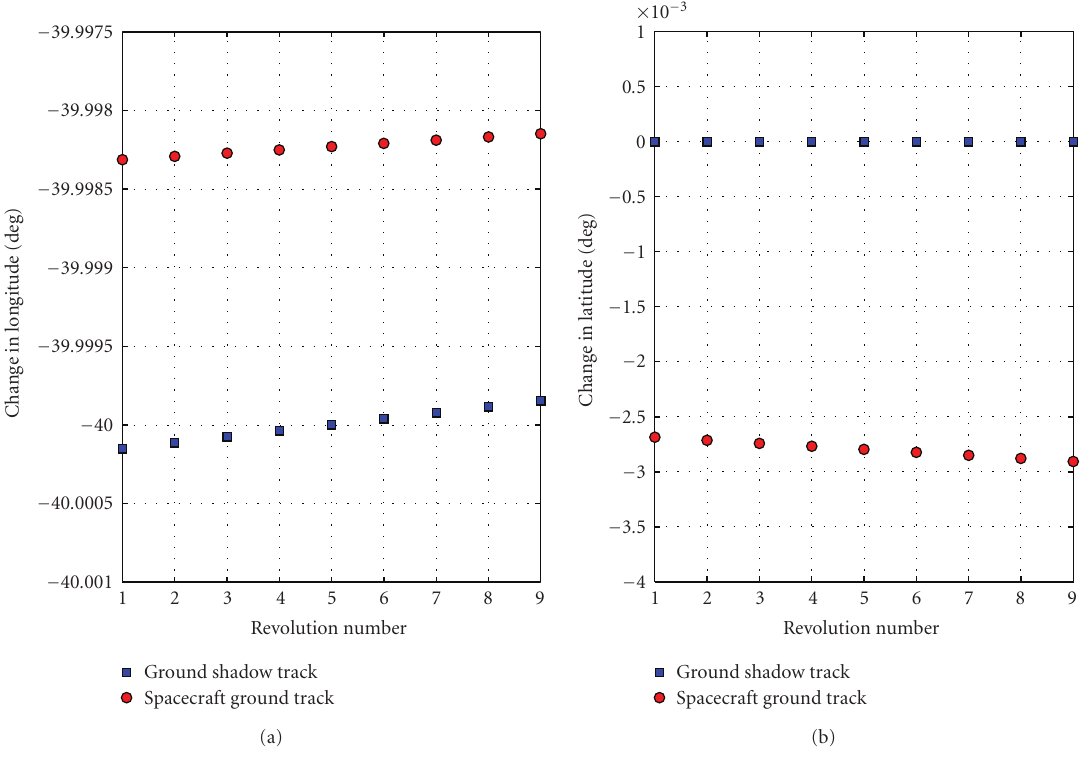
Figure 15: The variation in longitude and latitude for both shadow and spacecraft ground track of an RSTO.